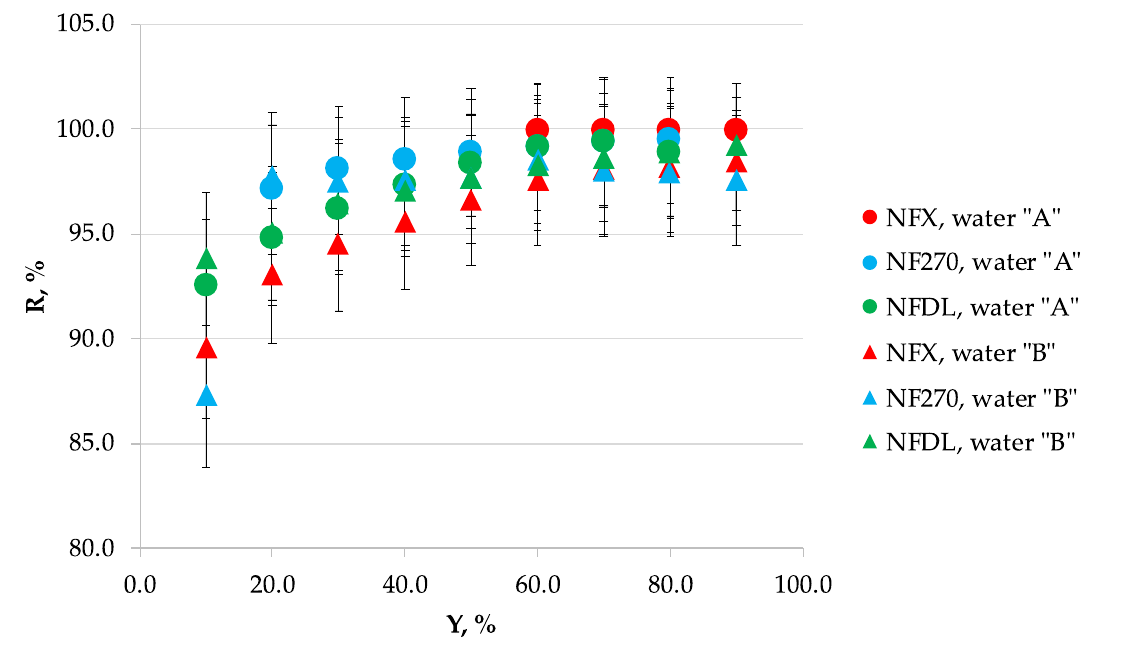
Figure A1. Rejection coefficient, R, of SO 42 − as a function of permeate recovery, Y, for NFX, NF270 and NFDL nanofiltration membranes and mine waters “A” (0.384 g/L as Cl − , 1.02 g/L as SO 42 − , 0.107 g/L as Na + , 0.142 g/L as Mg 2+ , 0.312 g/L as Ca 2+ ) and “B” (33.2 g/L as Cl − , 0.937 g/L as SO 42 − , 19.5 g/L as Na + , 0.990 g/L as Mg 2+ , 0.771 g/L as Ca 2+ ).